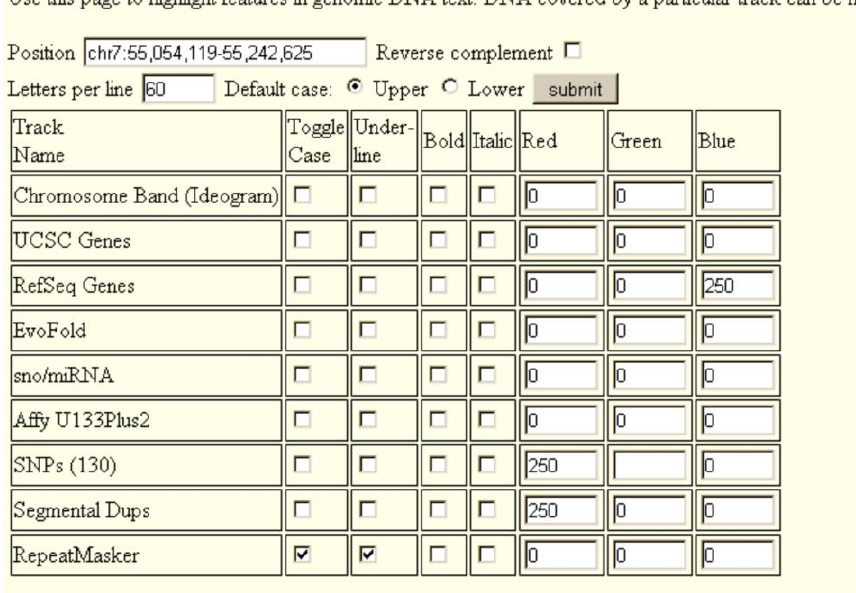
FIGURE 3. Screenshot of completed “Extended DNA Case/Color Options” table for labeling/masking DNA sequences retrieved from UCSC GB.